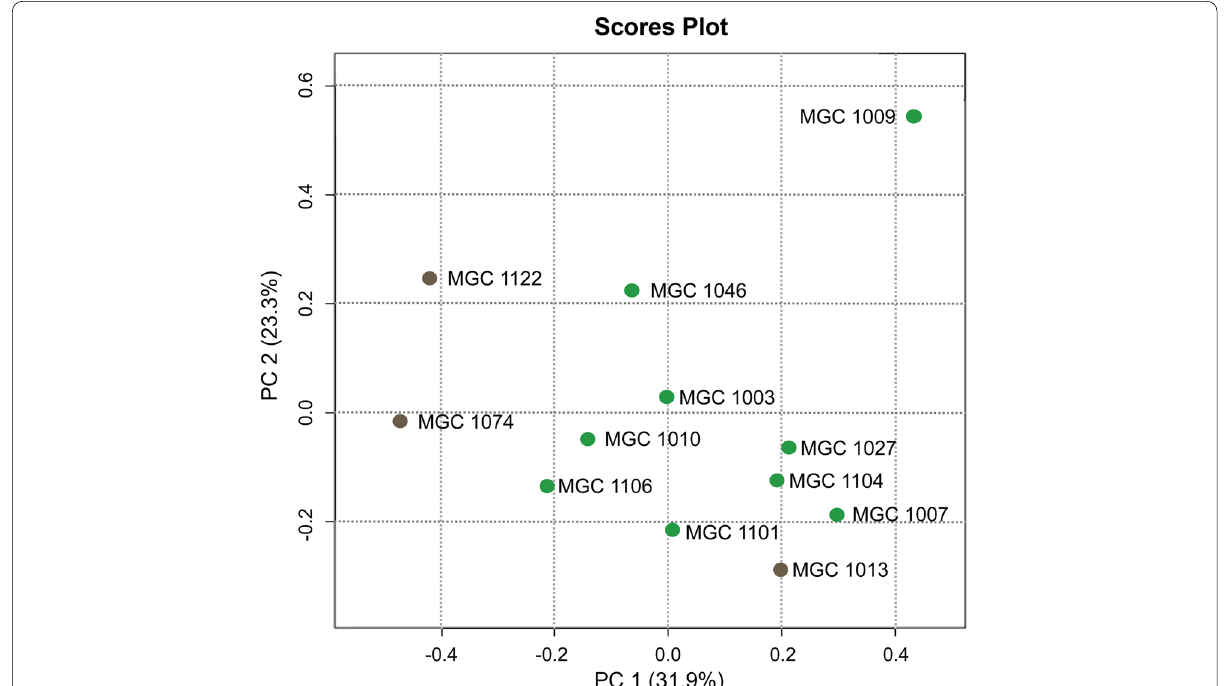
Fig. 2 Principal component analysis (PCA) score plot of the 12 different genotypes based on 1 H‑NMR profiles of polar extracts (PF). This graph shows the differences in metabolic profiles of compounds in the extracts of the different varieties. PCA was performed using MetaboAnalyst 5.0 with auto‑scaling. Green dots denote Δ 9 ‑tetrahydrocannabinol (THC)‑rich varieties; brown dots denote cannabidiol (CBD)‑rich